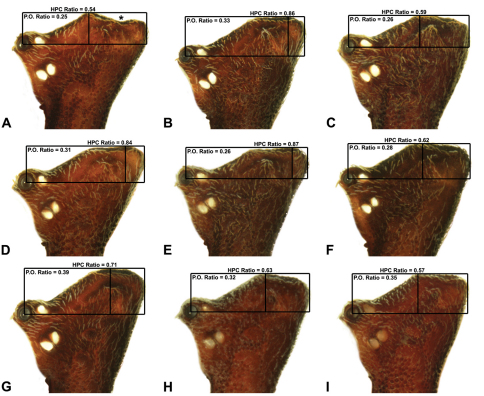
Lateral ‘head’ profiles of males of species of Austrarchaea from New South Wales (excluding the Border Ranges), showing variation in carapace shape as quantified by the post-ocular ratio (P.O. Ratio) and ratio of highest point of carapace relative to post-ocular length (HPC Ratio): A, holotype A. monteithi sp. n.; B, holotype A. christopheri sp. n.; C, holotype A. platnickorum sp. n.; D, holotype A. binfordae sp. n.; E, holotype A. milledgei sp. n.; F, holotype A. mascordi sp. n.; G, holotype A. smithae sp. n.; H, holotype A. mcguiganae sp. n.; I, holotype A. helenae sp. n. Asterisks (*) denote concave depressions.